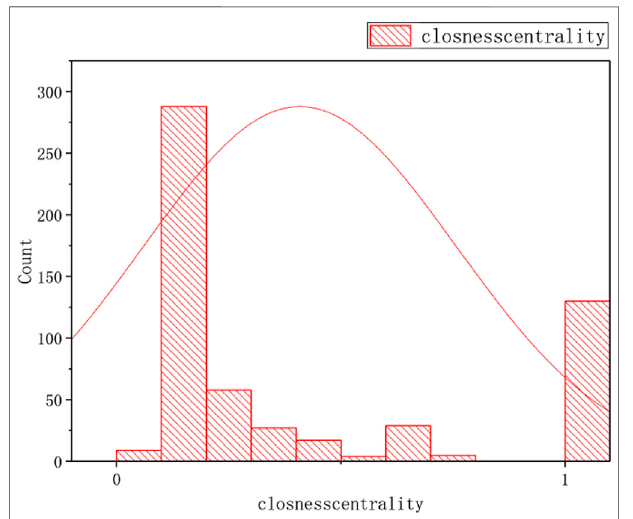
FIGURE 10 | The distribution of RangeRank of the TOA Network: Plot the number of the number of RangeRank on the vertical Y -axis against RangeRank on the horizontal x